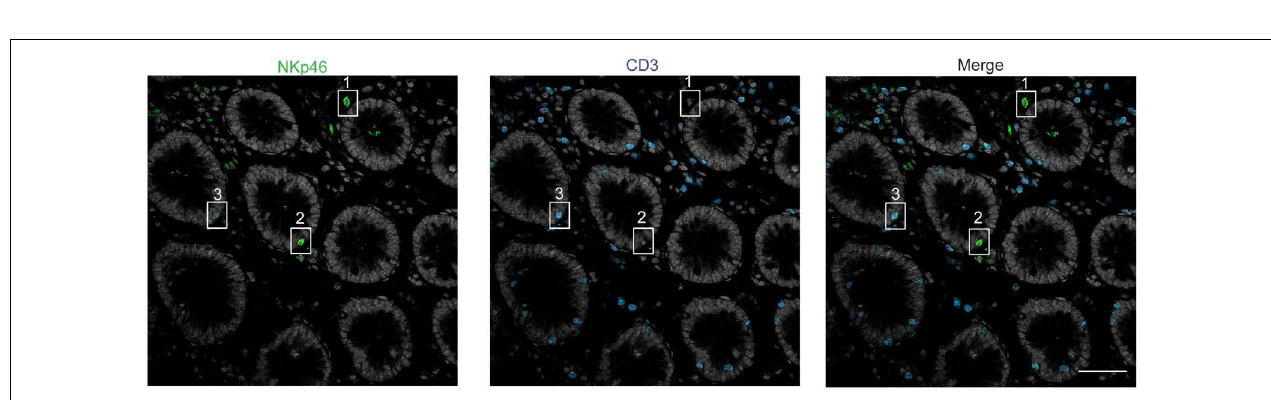
FIGURE 4 | Distribution of NKp46 + cells in the gut. (A,B) Frozen sections of human ileum (A,B) or of human colon (C,D) were stained with polyclonal anti-NKp46 serum (green), anti-CD20 mAb (red), and anti-CD3 mAb (blue).